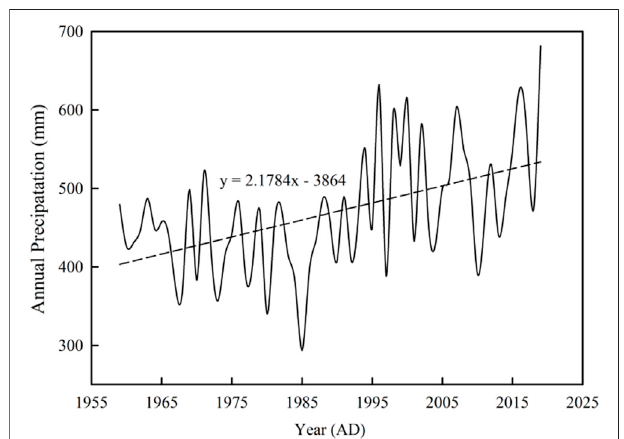
FIGURE 6 | The annual precipitation data from the Daxigou meteorological station. The solid line denotes the measured annual precipitation from 1959 to 2019. The dashed line is the linear fi t of the annual